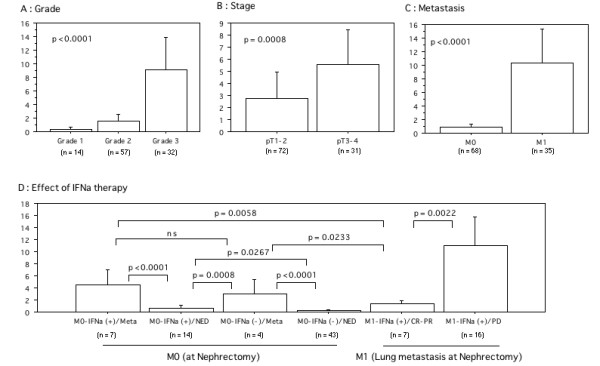
T (tumor)/N (non-tumor) values of IFNAR2 mRNA expression in kidney. A; In Grade 1 to 3 tumors. B; In pT1,2 and pT3,4 tumors. C; In metastasis (+) and (-). D; In effect of treatment of IFN-α (+) and watch-and-see (-). Meta; appearance of metastatic lesion after nephrectomy. NED; no evidence of disease. CR-PR; complete to partial response. PD; progression of disease. The data show the 95%